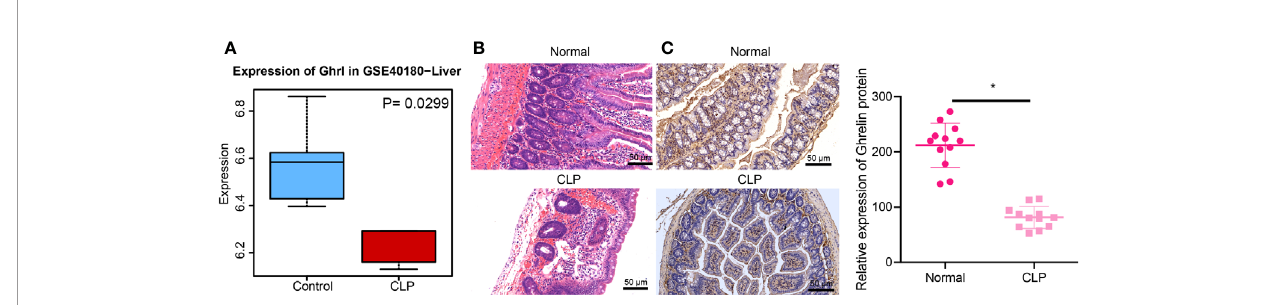
FIGURE 1 | Ghrelin is downregulated in small intestine of CLP rats. (A) , The box diagram indicates GHRL expression in normal liver tissues (blue box) and liver tissues of CLP sepsis model (red box) in the GSE40180 dataset. (B) , The pathological changes of small intestine after H&E staining (×200). (C) , Immunohistochemical detection of Ghrelin expression in small intestinal tissues (×200). * p < 0.05 vs. normal group. The measurement data were expressed as mean ± standard deviation. The independent sample t -test was used to compare data between two